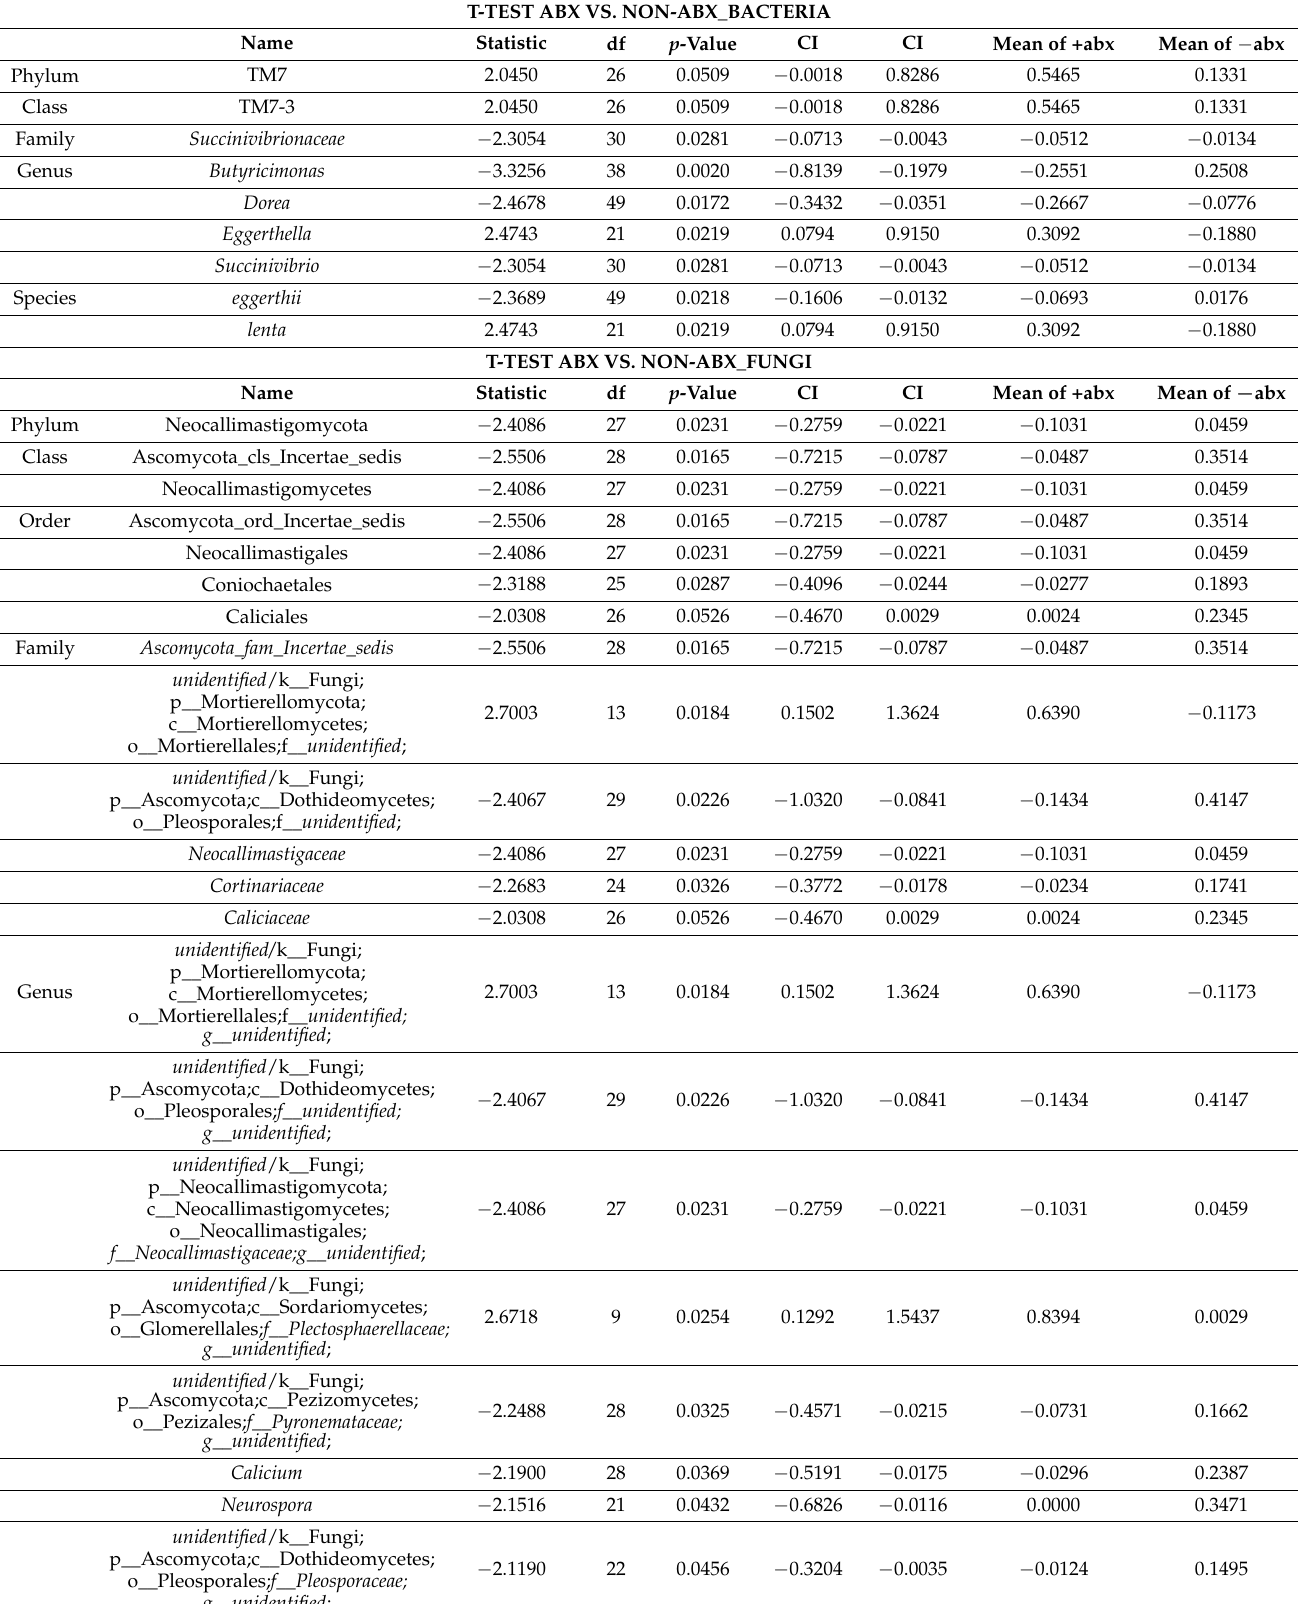
Table 10. Significant p -values using the t -test for +ABX vs. -ABX for bacteria and fungi at all taxa levels. T-TEST ABX VS.